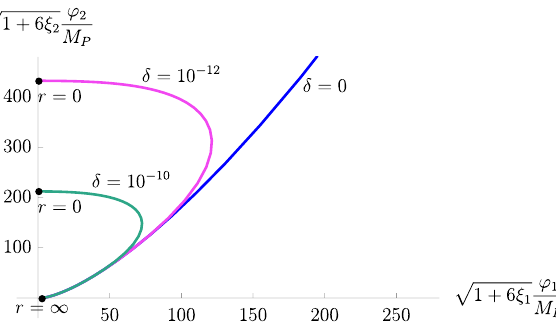
Figure 3 . The family of singular instantons of the model (4.21)|(4.24), corresponding to di(cid:11)er- ent values of the parameter (cid:14) in the higher-dimensional derivative term. One observes that this derivative term regularizes the logarithmic divergence of the radial (cid:12)eld and makes the latter (cid:12)nite at the center of the instanton. The parameters of the model are (cid:24) 1 = 1, (cid:24) 2 = 1 : 1 and (cid:21) =